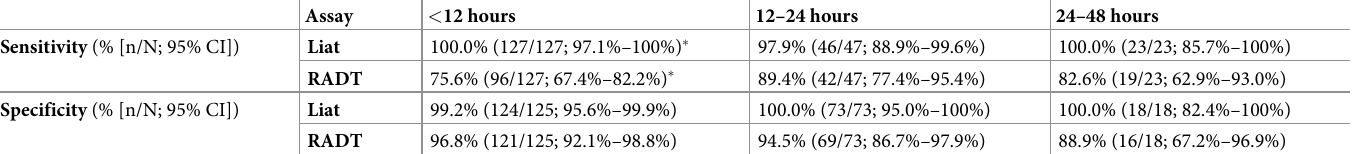
Table 3. Comparison of the assays’ performance against final results.